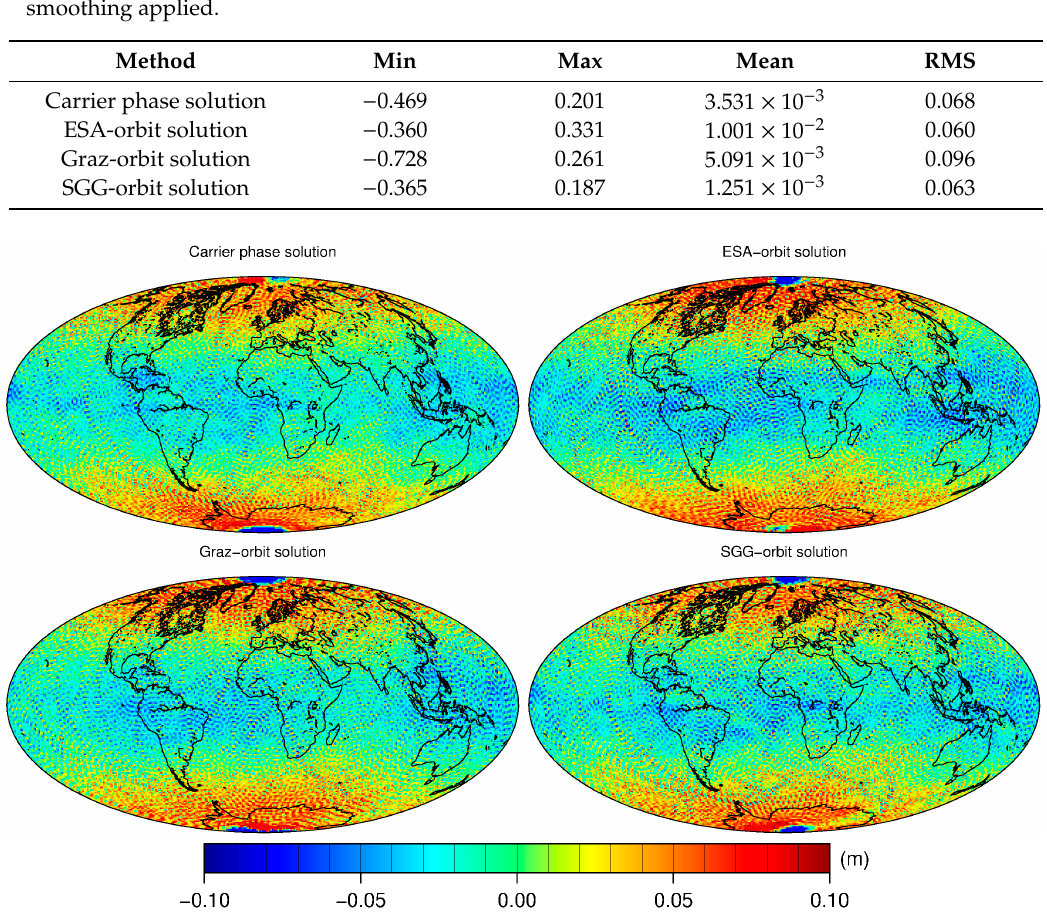
Figure 5. Geoid height errors of the recovered spherical harmonic coefficients w.r.t. EIGEN-6C4 with the 500 km Gaussian smoothing applied.